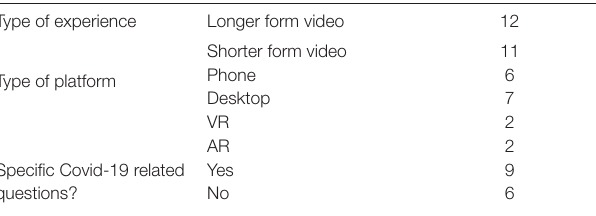
TABLE 1 | Survey information of interest from 15